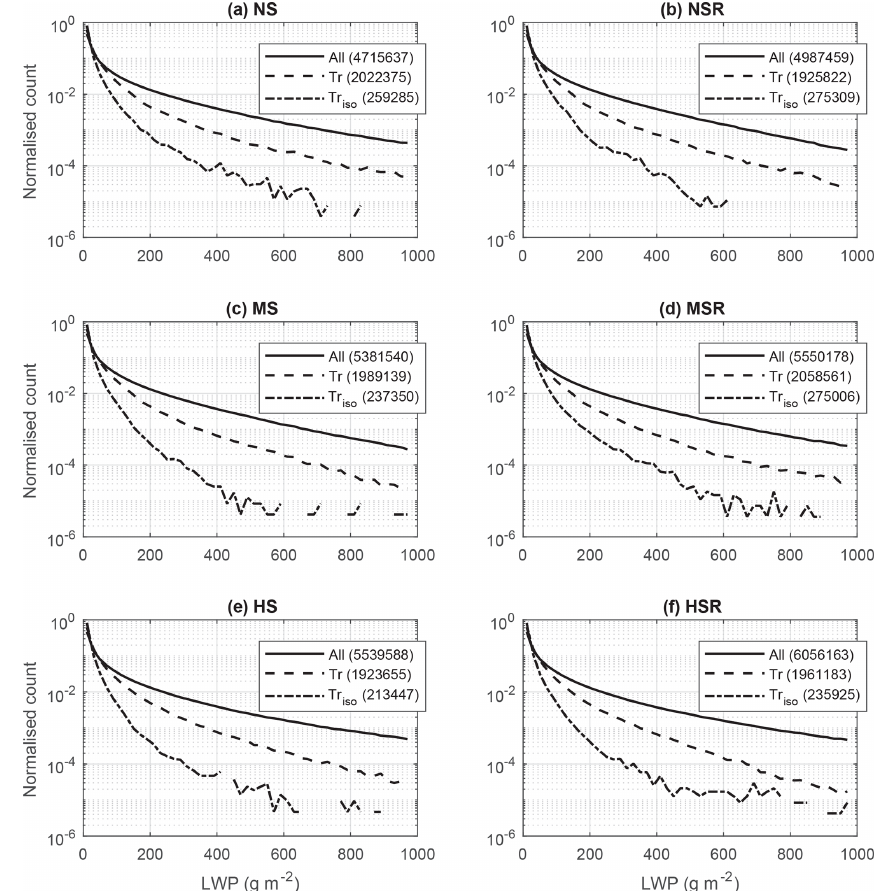
Figure 6. Normalised histograms of LWP for all six runs. The continuous black lines (“All” in the legend) represent the distribution for all pixels in the domain with LWP > 0 . 6gm − 2 . The dashed lines represent the distributions only for the pixels that are tracked by ForTraCC (“Tr” in the legend). The dotted–dashed lines only represent the distributions for the pixels that are tracked by ForTraCC and for which no merger or split was detected (“Tr iso ” in the legend). Within the legend, the numbers in parentheses are the total number of pixels in each case. All 2min output time steps between 11:00 and 18:00LT are